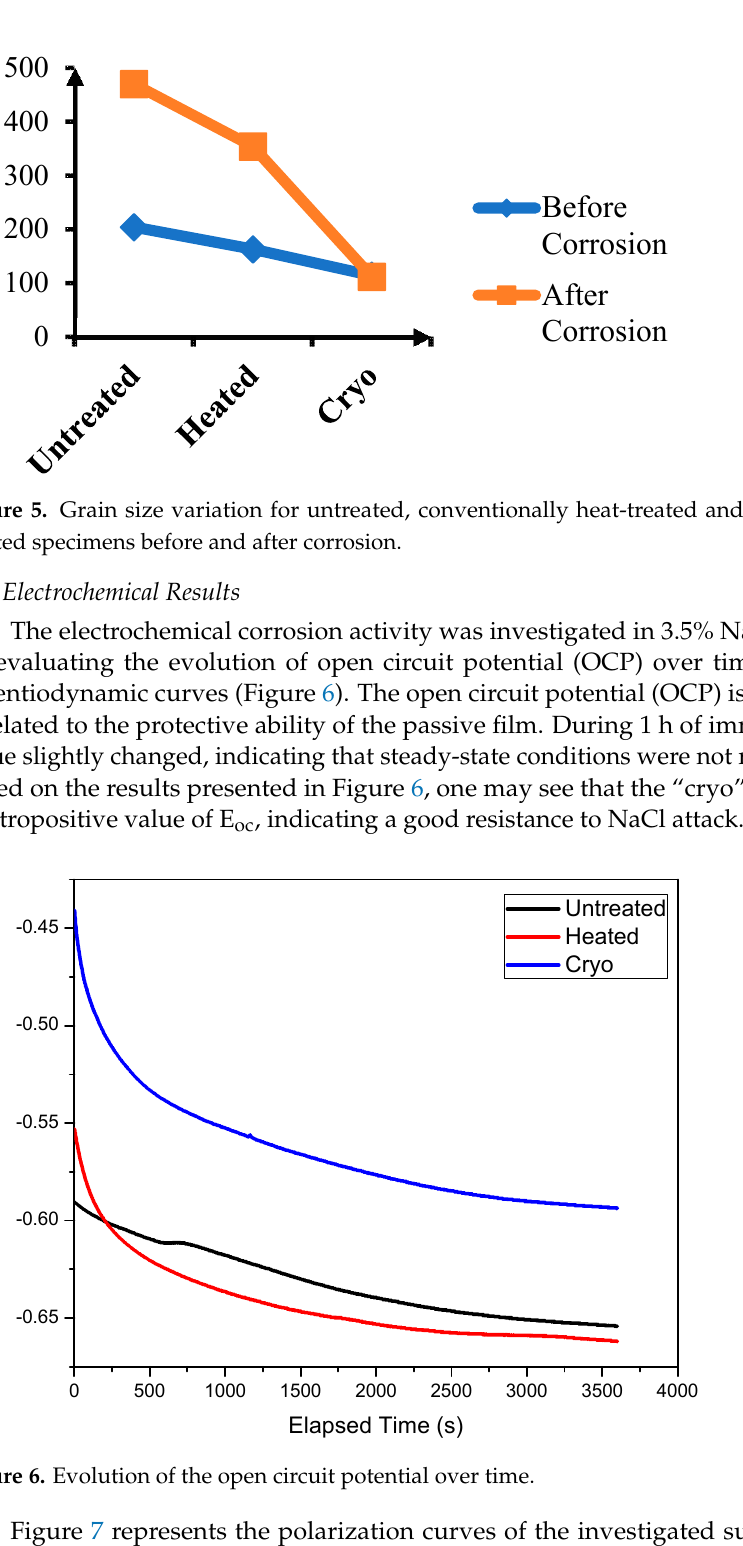
Figure 5. Grain size variation for untreated, conventionally heat-treated and 16 h cryogenically treated specimens before and after corrosion.